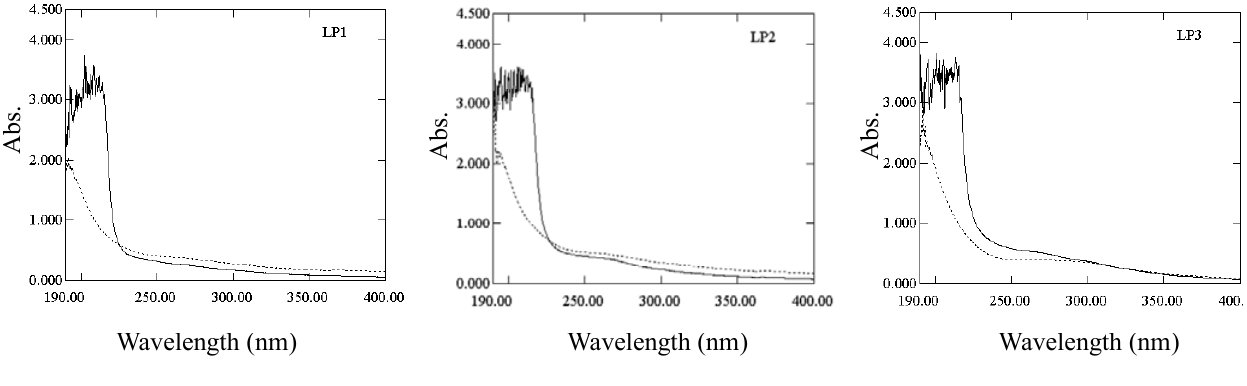
Figure 2. UV spectra of β -elimination reactions of LP1-3. “–” represents the absorption of LP treated with sodium hydroxide, and “-” represents the absorption of non-treated